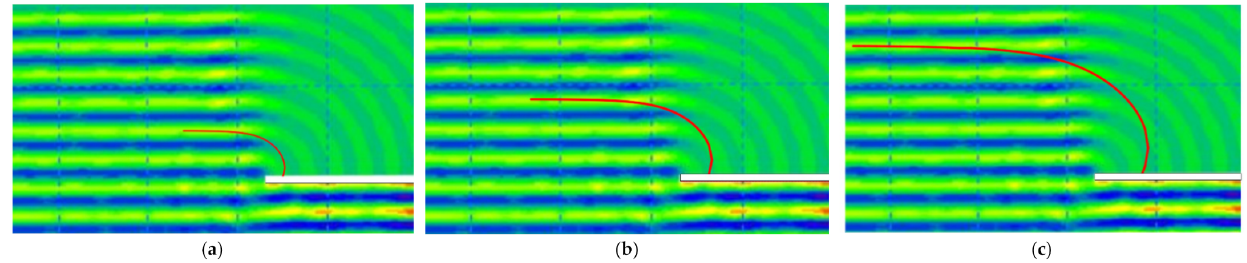
Figure 7. Comparison between wave front (obtained with flat bottom configuration) and hyperbolic tangent profile (red line), images from ( a – c ) show profiles sketched out, starting with fronts gradually further from the headland.